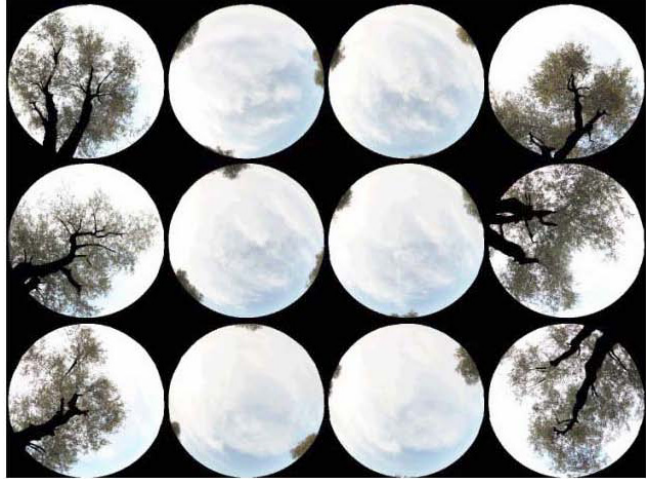
Figure 4. Example of a set of transects describing a sampling unit/vegetation